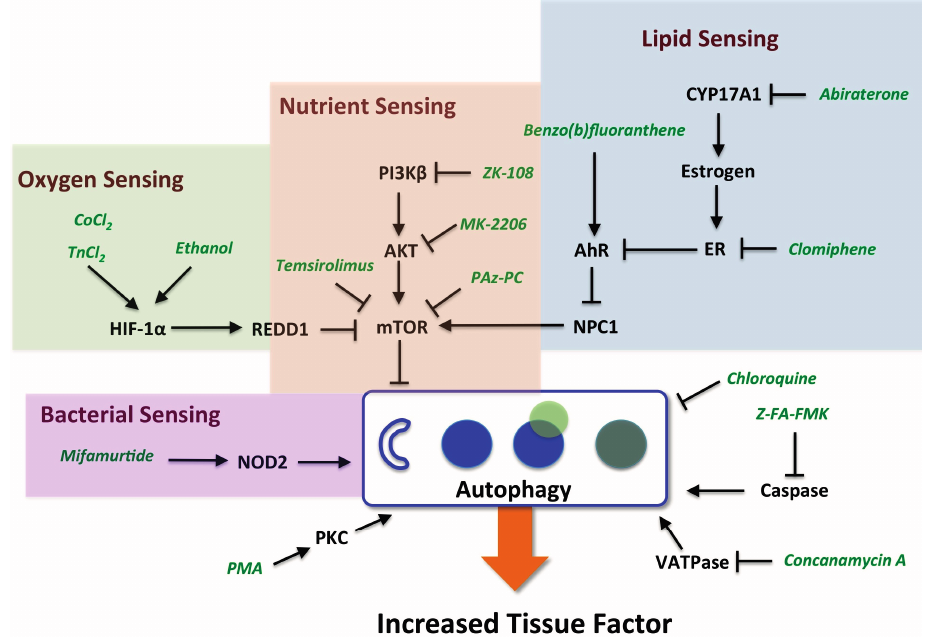
Figure 2. Schematic representing pathway mechanisms that regulate the cell surface expression of TF. Mechanisms identified in the current study that increase TF in the BioMAP 3C system and regulate autophagy by impacting nutrient, oxygen, lipid or bacterial sensing functions as detailed in the text. The process of autophagy involves nucleation of autophagosomes, engulfment of cellular constituents, fusion with lysosomes, and subsequent degradation of the